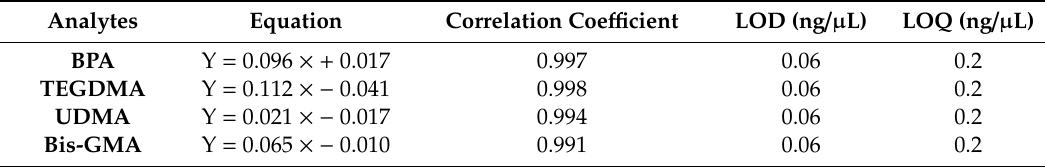
Figure 2. HPLC chromatogram of an artificial saliva blank (black) and an artificial saliva standard solution (red) and a methanolic-standard solution (green). Table 2. Calibration and sensitivity data of the four examined